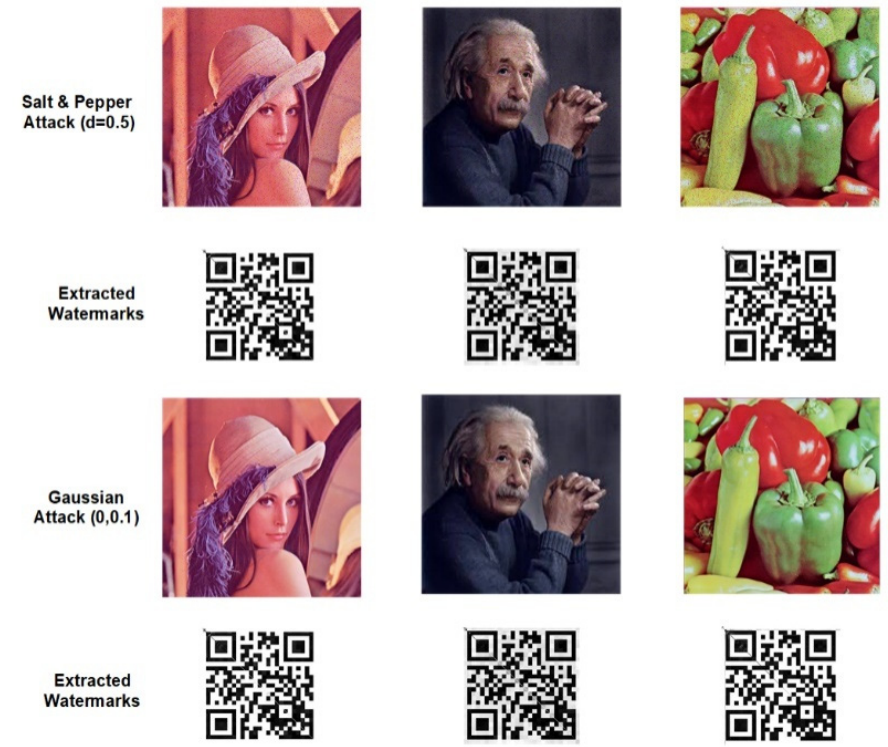
Figure 8. Noise attacks on sample images and extracted watermarks.